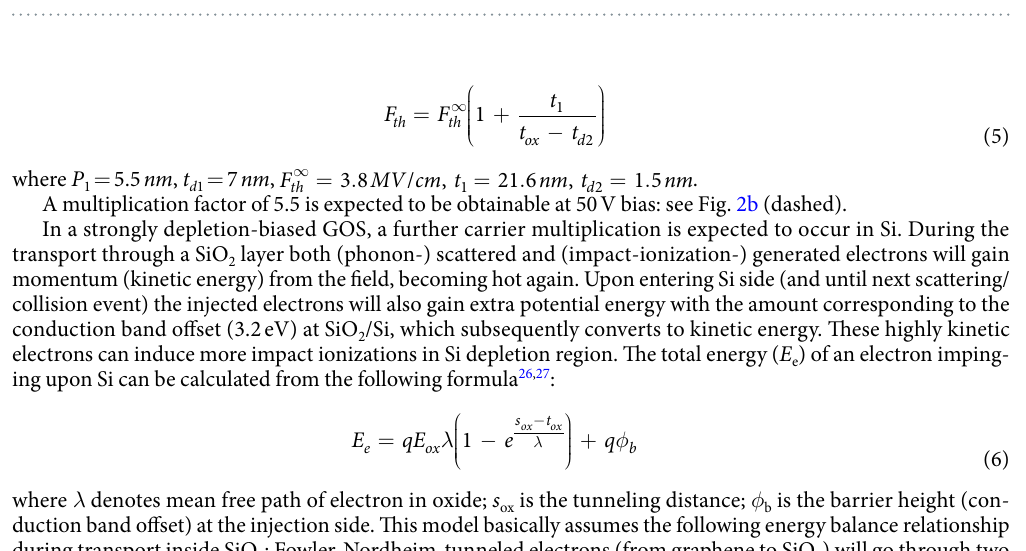
Figure 2. Field distribution and carrier multiplications in a GOS structure. ( a ) Electric field distribution in 8LG/SiO 2 (10 nm)/n-Si under 50-V inversion bias: calculated before a breakdown process embarks. ( b ) Electron multiplication factors calculated as a function of oxide field: in SiO 2 layer (dashed) and in Si depletion region